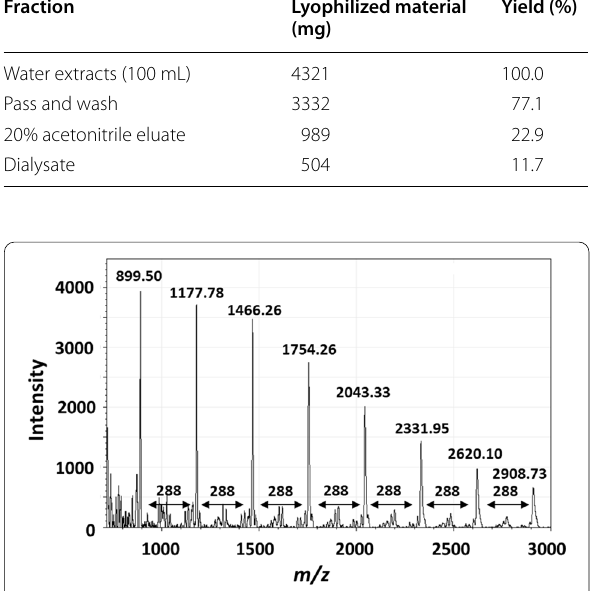
Fig. 3 MALDI-TOF MS spectrum of the purified aqueous extract of A. zerumbet